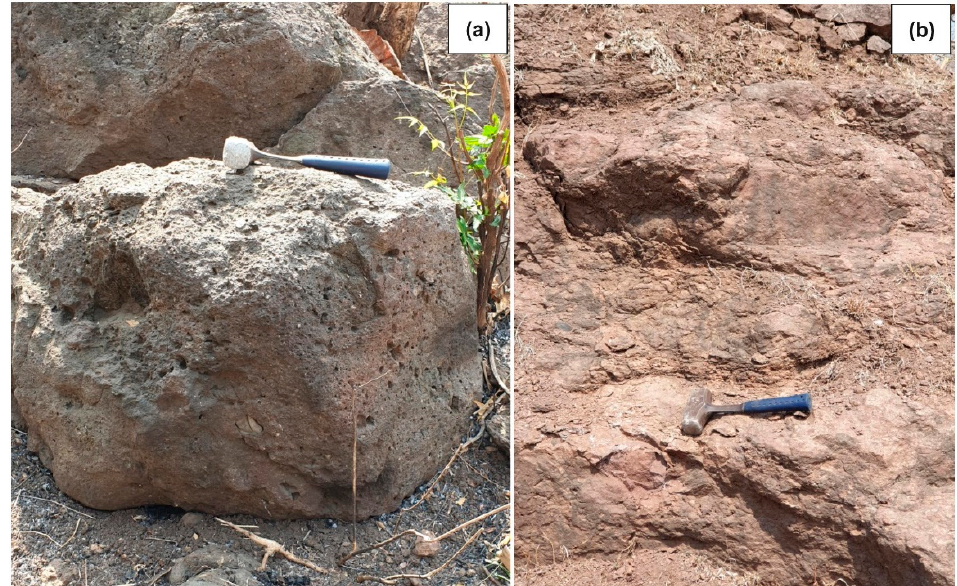
Figure 2. Close views of field exposures of carbonatite agglomeratic/brecciated intrusions. ( a ) Medium to coarse phenocrysts/xenocrysts/xenoliths embedded within the carbonate matrix exposed near the village Rajawat. ( b ) Contains larger xenoliths of sedimentary rocks, basalts, carbonatites, alkaline rocks together with xenocrysts/phenocrysts exposed near the village Manka. The ASACC has been dated by 40 Ar– 39 Ar method, which suggests its emplacement at